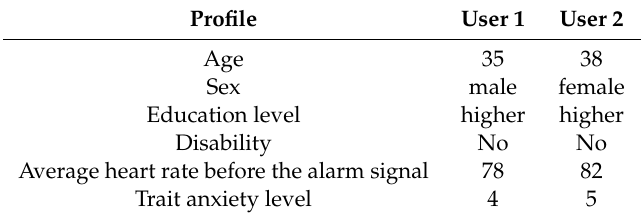
Table 5. User profile and trait anxiety level before the